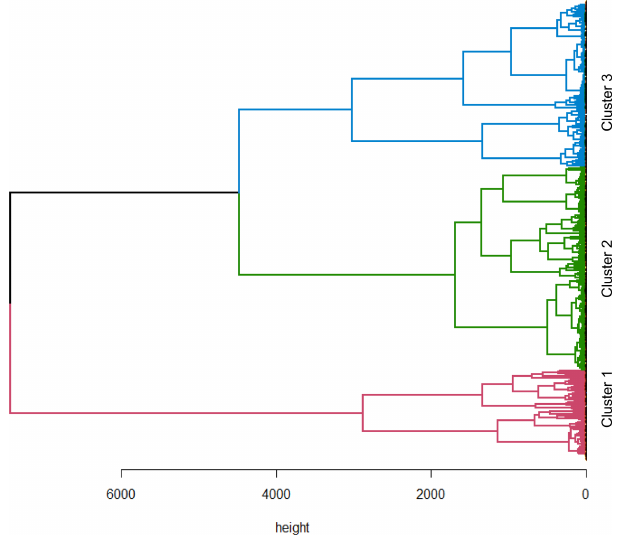
Figure 2. Cluster dendrogram illustrating the sorting process lead- ing to three most similar clusters. Source: